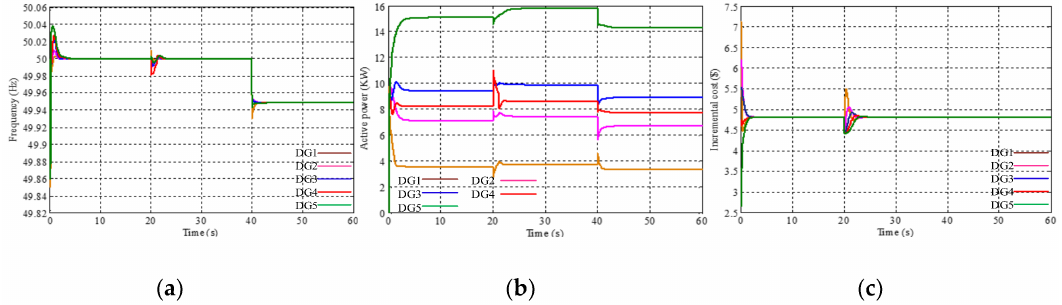
Figure 9. Simulation results with communication failure. ( a ) Frequency; ( b ) Active power; ( c ) Incremental cost λ